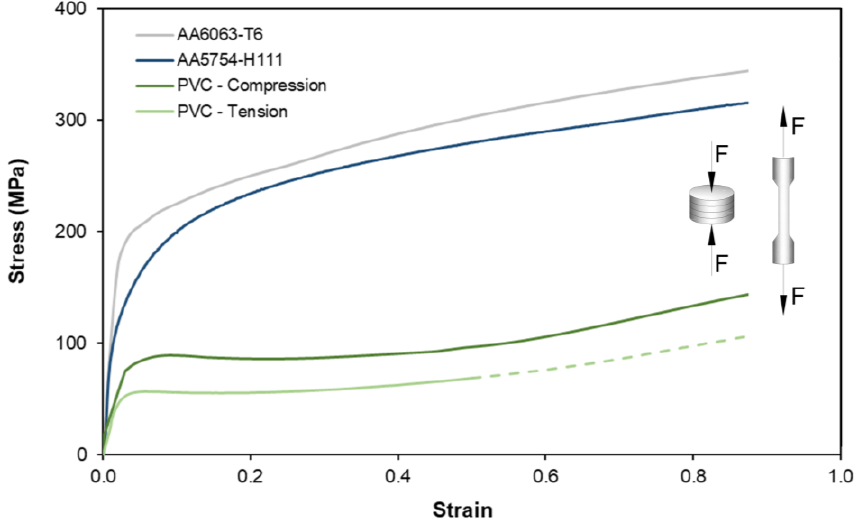
Figure 2. Effective stress – strain curves of the supplied materials with schematics of the mechanical characterization tests. characterization